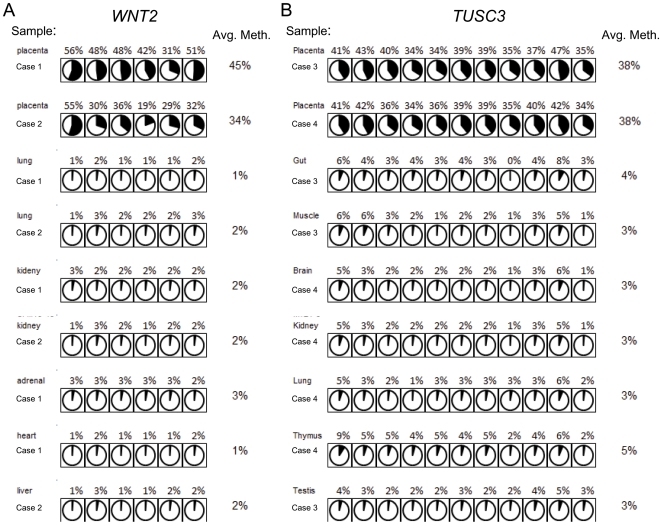
Tissue-specific DNA methylation of WNT2 and TUSC3.(A) DNA samples from two independent fetuses associated with placental methylation at the WNT2 promoter were investigated by bisulfite pyrosequencing. None of the tissues (lung, kidney, adrenal, heart and liver) other than placenta was methylated. (B) DNA samples from two independent fetuses with placental methylation at the TUSC3 promoter were investigated by bisulfite pyrosequencing. None of the tissues (lung, kidney, gut, muscle, brain, thymus and testis) other than placenta was methylated. Each circle represents a CpG site in a sample. Area shaded in black is proportional to the methylation level of the CpG site indicated by pyrosequencing.